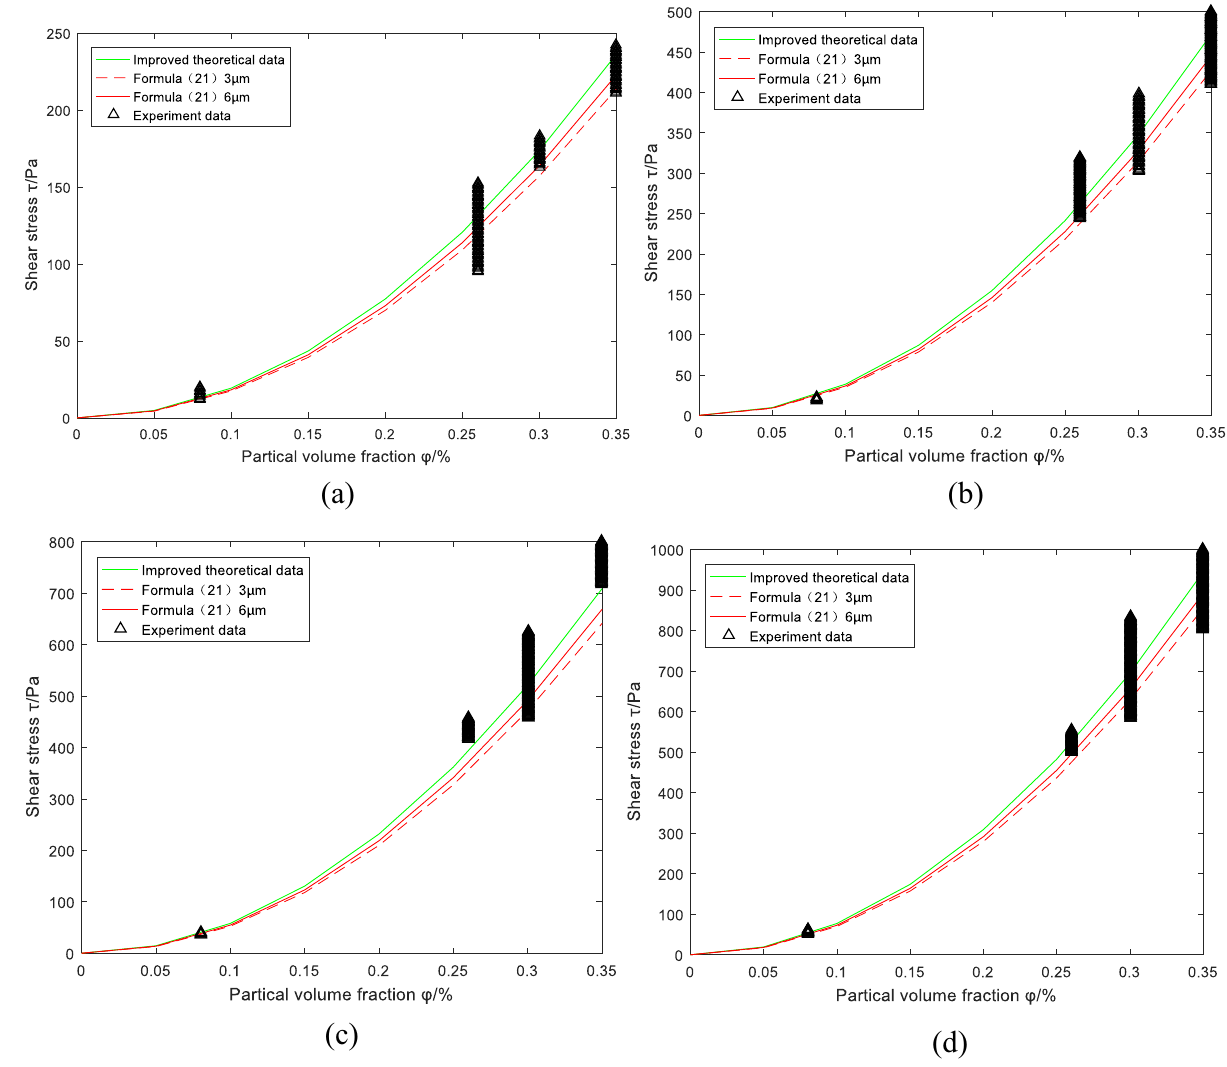
Figure 6: When the particle volume fraction is constant, the relationship between magnetic induction intensity and shear stress graph: ( a ) particle volume fraction is 5%; ( b ) particle volume fraction is 10%; ( c ) particle volume fraction is 15%; and ( d ) particle volume fraction is